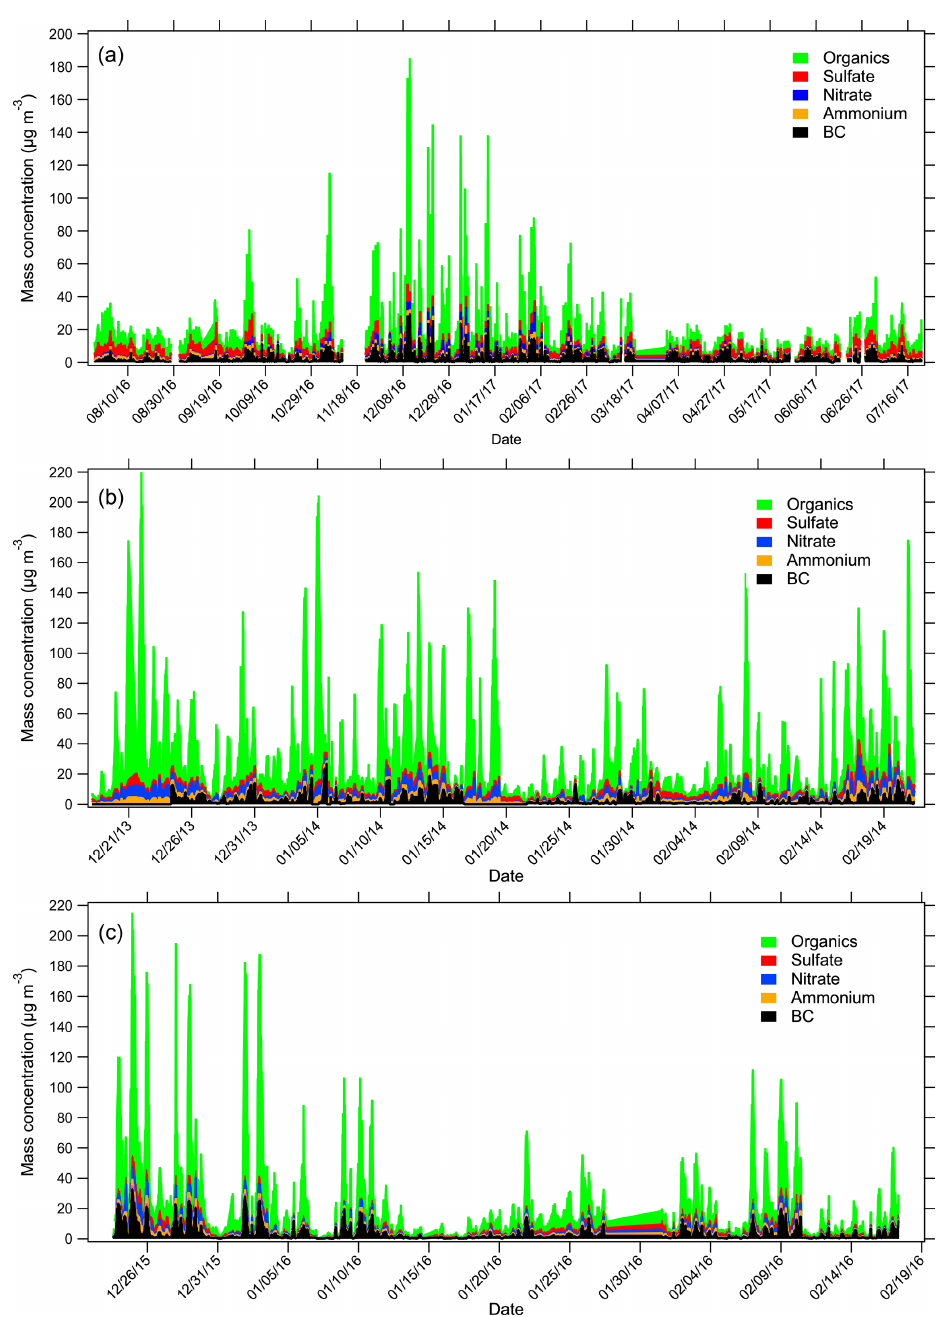
Figure 2. Time series of the main submicron aerosol components. (a) The 1-year period starting on 26 July 2016 and ending on 31 July